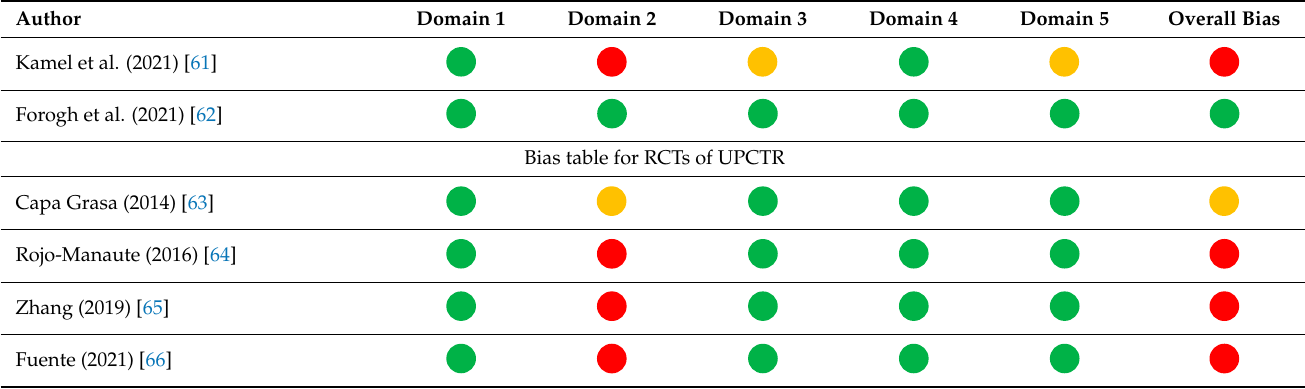
Table 1. Bias table for RCTs of UPIT and UPCTR.